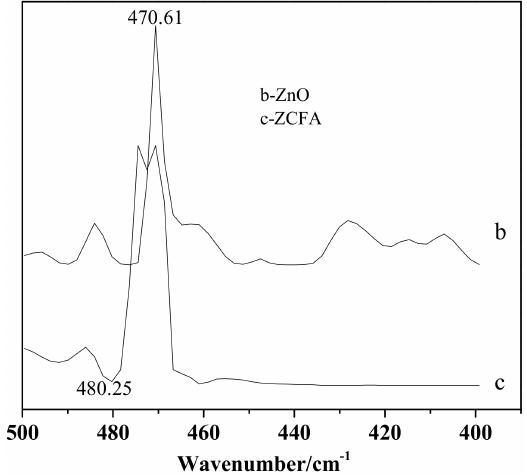
Figure 15. FTIR of ZnO and ZCFA powders at 400–500 cm -1